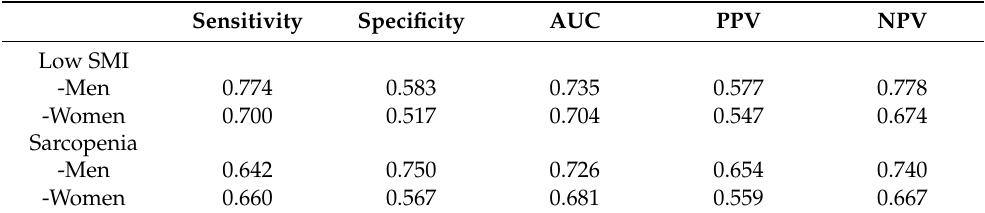
Table 3. Accuracy of low TMT for identifying low SMI and sarcopenia.